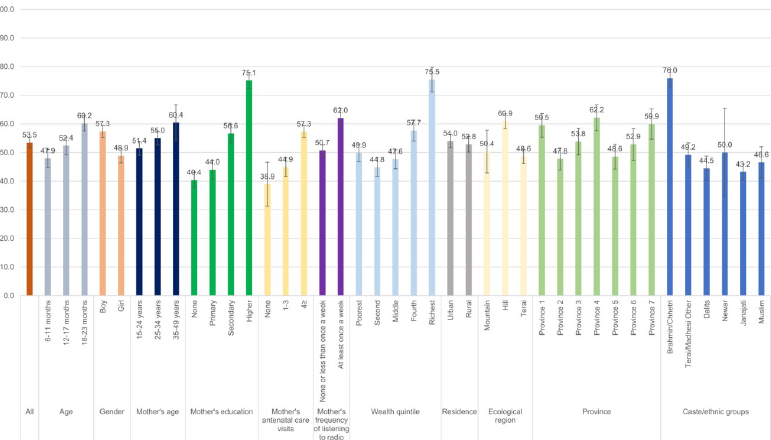
Fig 3. Percentage of Nepalese children aged 6 to 23 months consuming dairy products by sociodemographic factors.